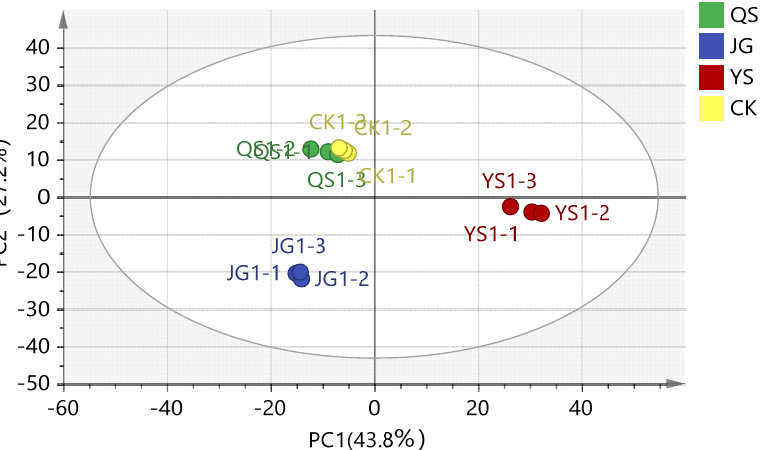
Figure 2. Score scatter plot of a principal component analysis composed of all metabolites (R 2 X[1] = 0.438, R 2 X[2] =